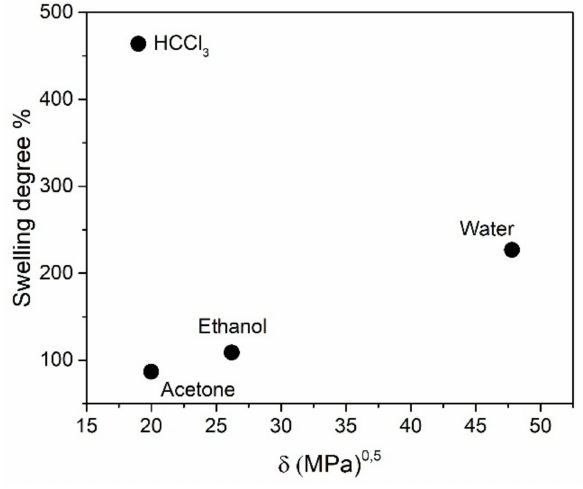
Figure 5. Percentage of swelling degree as a function of the Hildebrand parameter of the